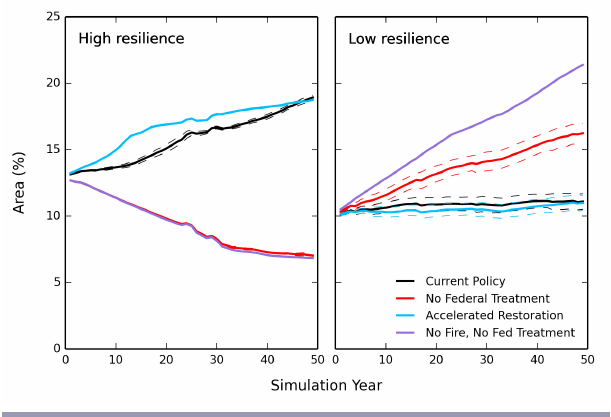
Fig. 10. Mean area of high- and low-resilience older forest structure for fire-prone potential vegetation types for different management scenarios. Broken lines indicate corresponding 95% confidence intervals for 15 replications.